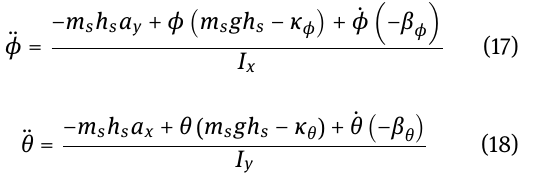
Figure 6. The steering wheel angle and vehicle speed re-